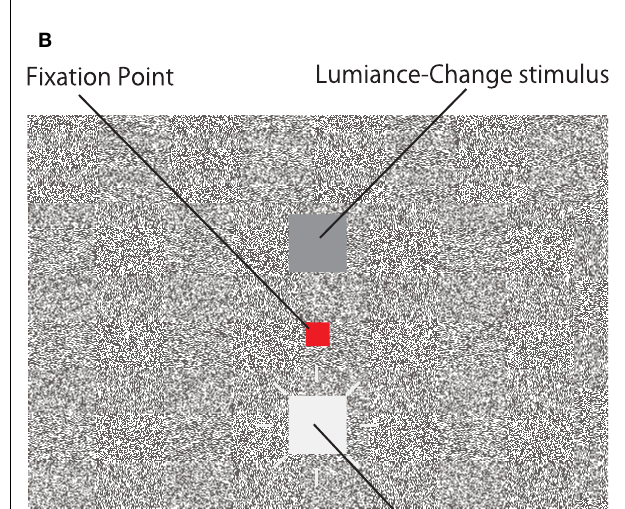
below or above the red fixation point (19.0 arcmin × 19.1